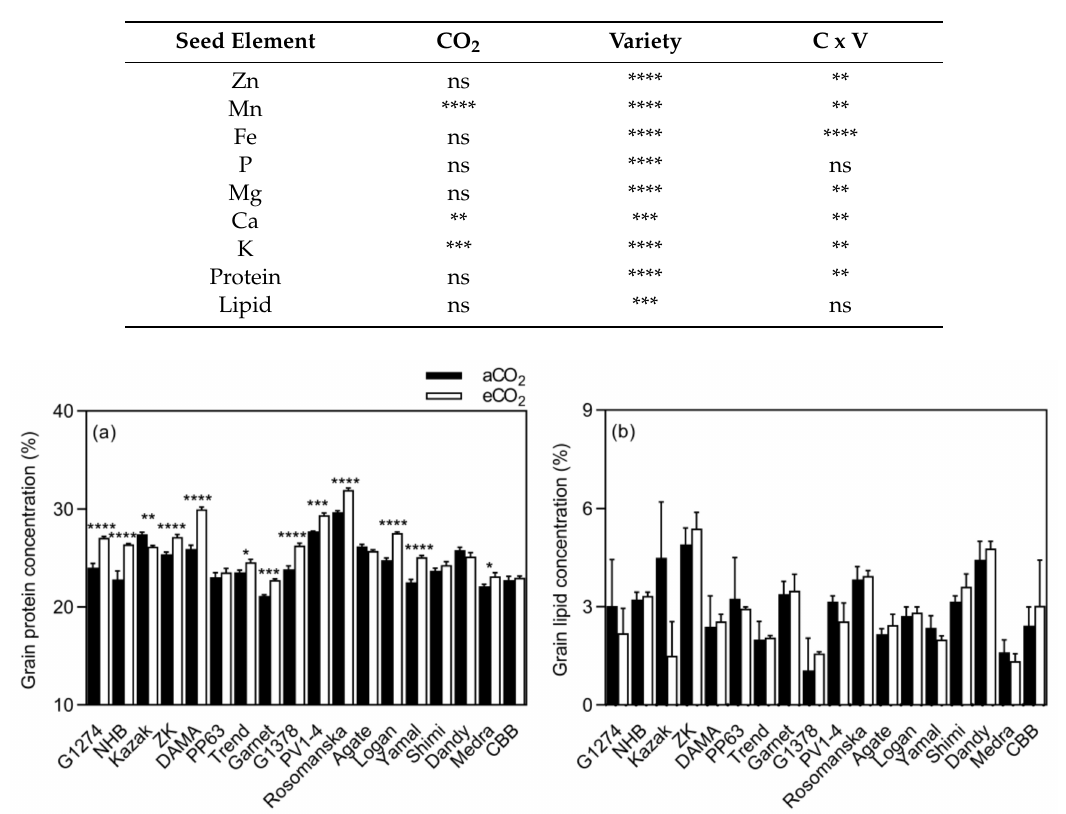
Figure 10. Influence of eCO 2 on soybean seed protein and lipid concentrations. ( a ) soybean seed protein and ( b ) lipid concentrations. Each bar represents the mean ± SE ( n = 10 plants). * p <